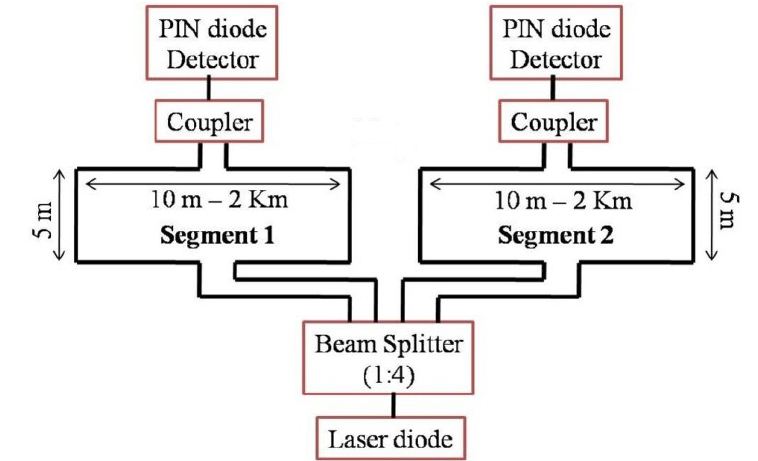
Figure 1. Experimental setup of single fiber zone.